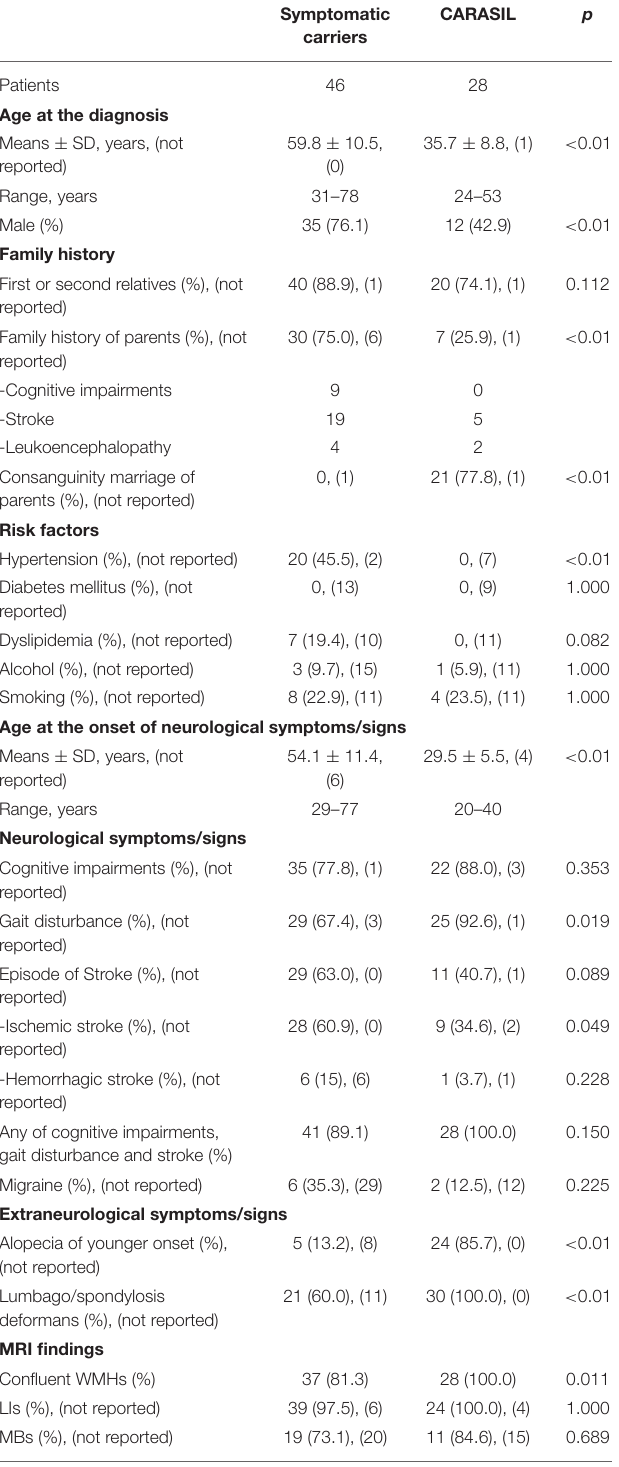
TABLE 3 | Summary of clinical and imaging information for patients with HTRA1 -related